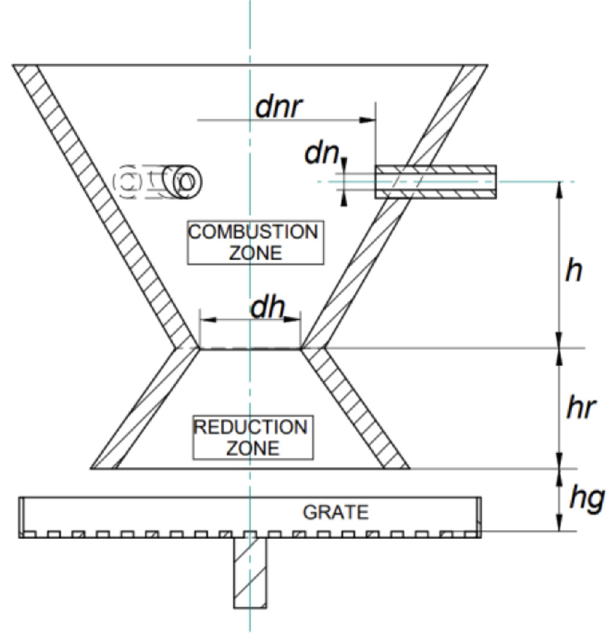
Fig. 2. Geometric parameters of gasi fi er